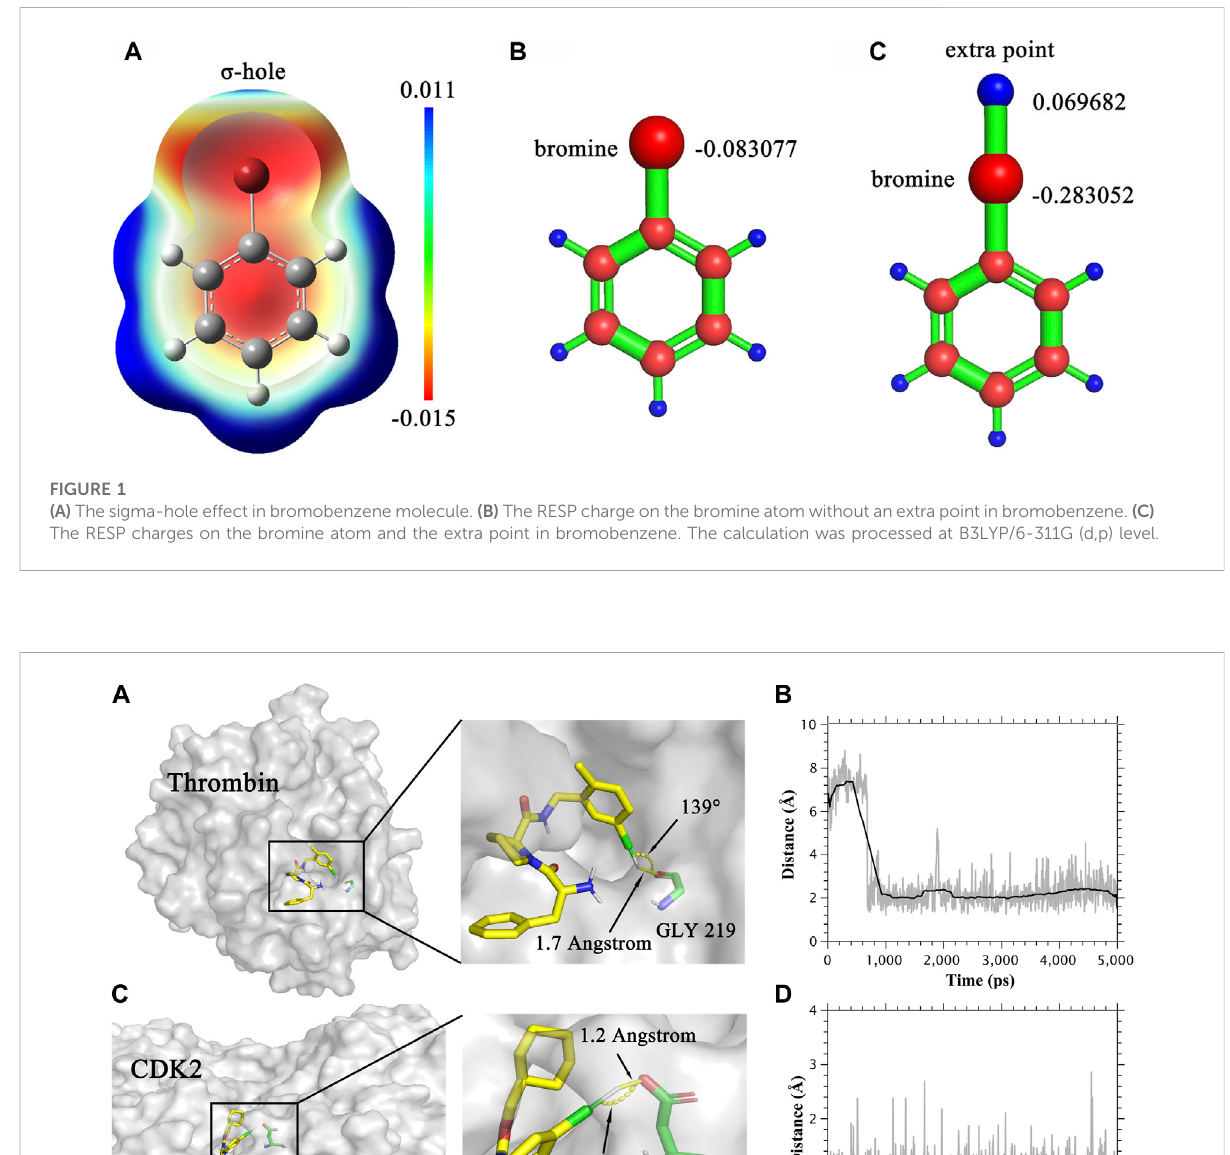
Table 1, MM/GBSA showed the highest R in CDK2 (0.78), p38 (0.70) Jnk1 (0.55) and OX1 (0.85) systems with the charge method of RESP_DFT. MM/PBSA showed the highest R in CDK2 (0.52) and OX1 (0.73) systems with the charge method of RESP_DFT. MM/GBSA only showed the highest R in the